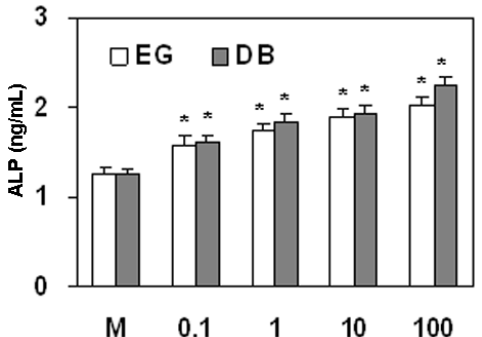
Figure 4. The effect of EG on ALP expression in MC3T3-E1